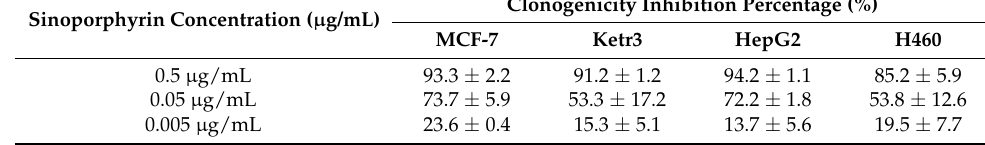
Table 1. The clonogenicity inhibition rates of sinoporphyrin sodium-PDT towards human cancer cells (%). MCF-7, breast adenocarcinoma; Ketr 3, renal carcinoma; HepG2, liver hepatoma; H460, large cell lung cancer.